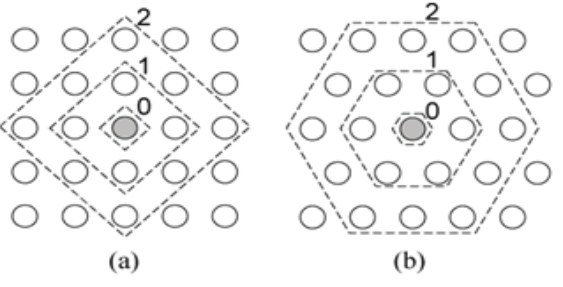
Fig. 2. Two commonly used topologies in SOM. (a) Rectangular. (b)